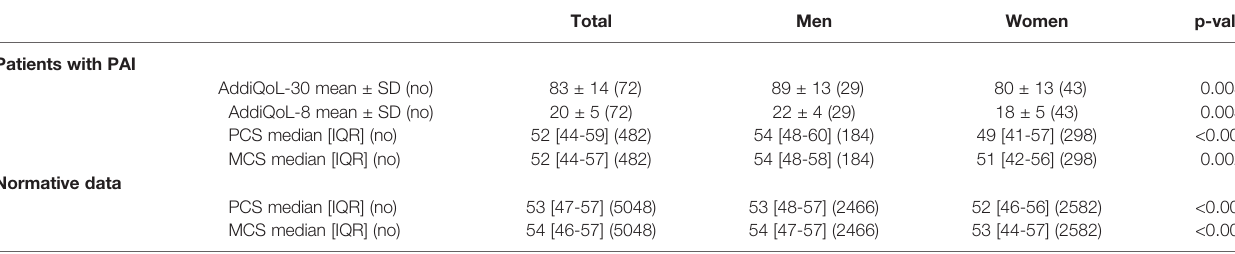
TABLE 3 | Quality of life in men and women with PAI compared to normative